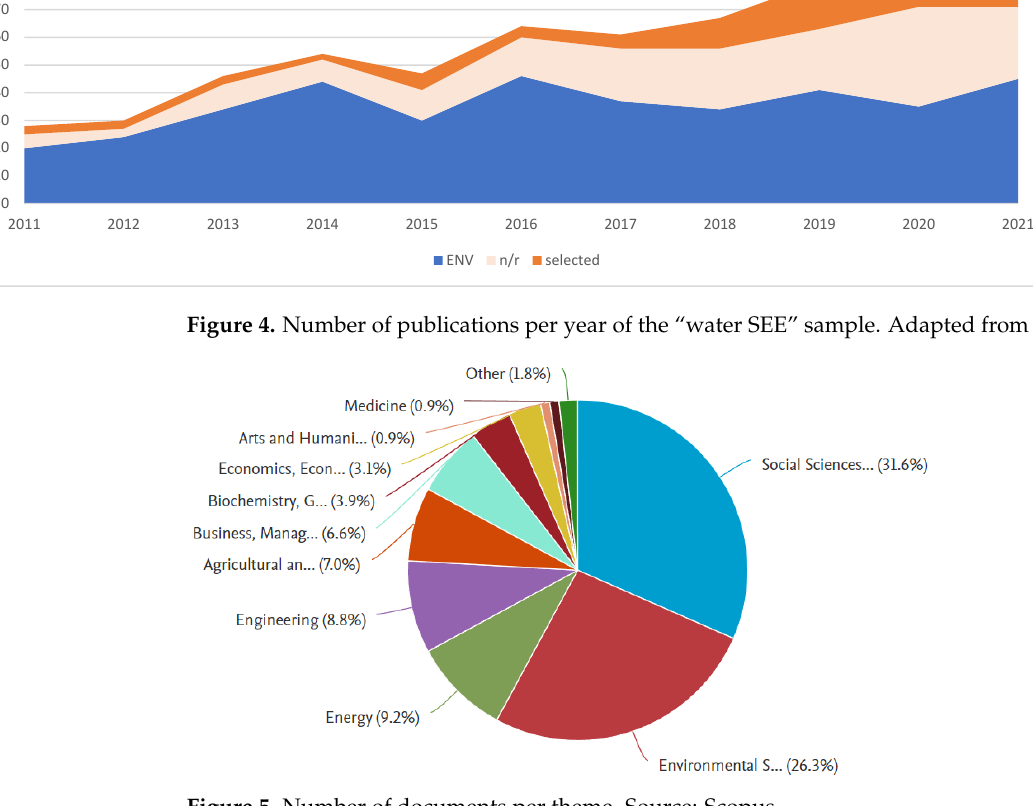
Figure 5. Number of documents per theme. Source: Scopus.